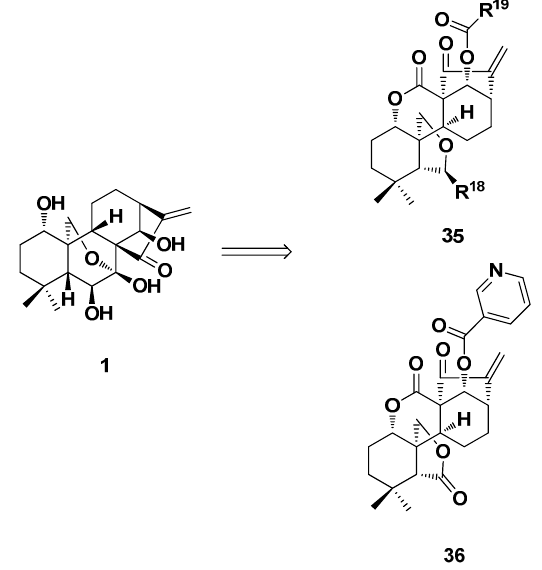
Figure 19. Enmein-type 6,7- seco -kaurane diterpenoid derivatives 35 and 36 .